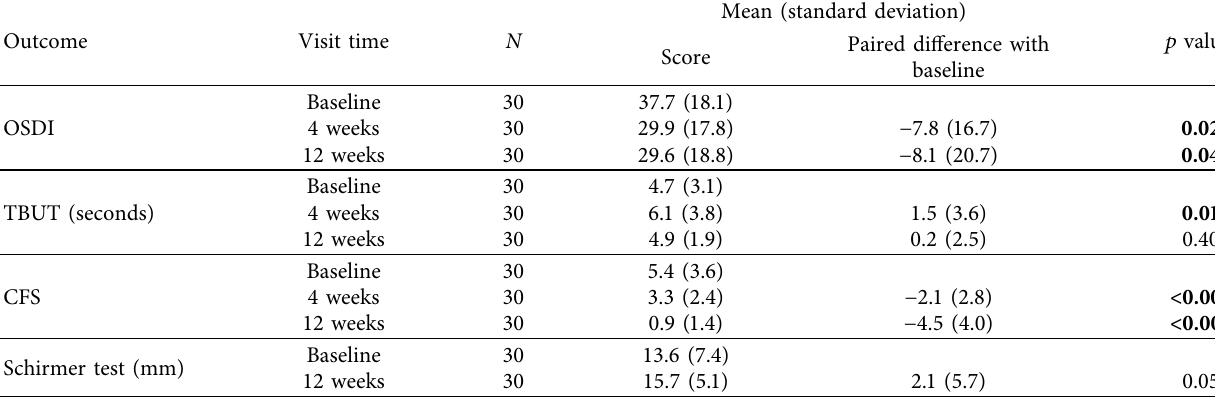
Table 2: Summary statistics for secondary outcomes by